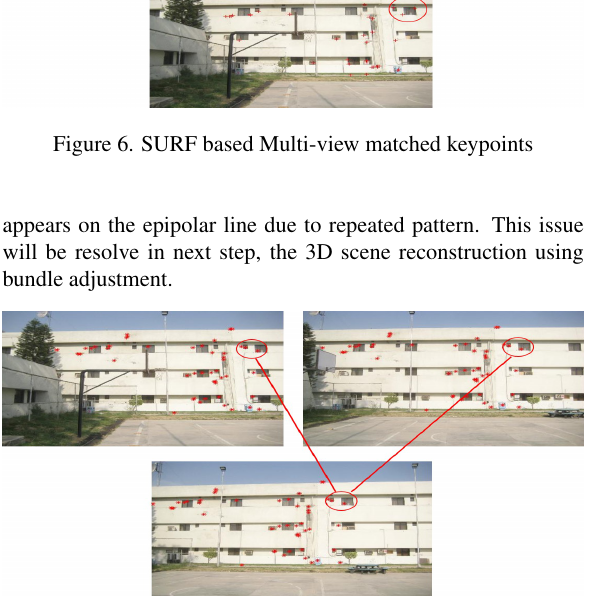
Figure 7. SIFT based Multi-view matched keypoints